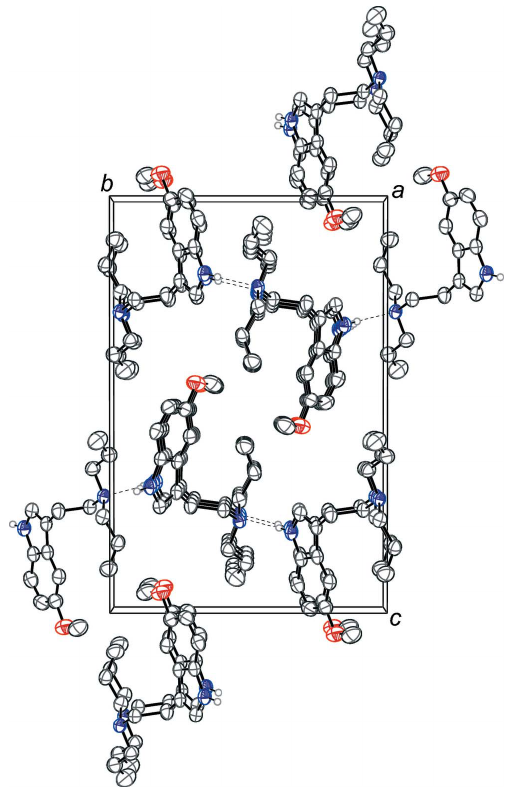
Figure 2 The crystal packing of 5-methoxy- N , N -diallyltryptamine, viewed along the a axis. The N—H (cid:2)(cid:2)(cid:2) N hydrogen bonds (Table 1) are shown as dashed lines. Displacement ellipsoids are drawn at the 50% probability level. Hydrogen atoms not involved in hydrogen bonding are omitted for clarity.